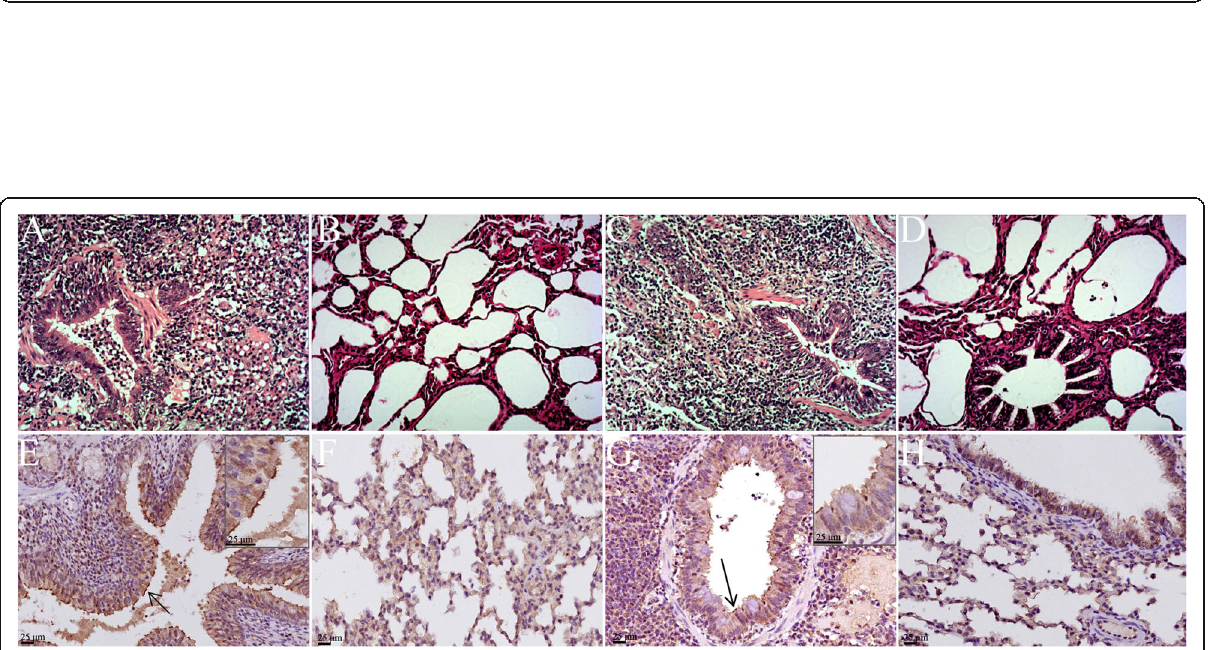
Fig. 4 IFA for the detection of mucus secretion in bronchi (longitudinal section) infected with M. hyopneumoniae. a and b represent immunostaining with MUC5B in bronchi of Bama mininature pigs infected with M. hyopneumoniae strain JS at 200 × magnification and 400 × magnification, respectively. c and d represent immunostaining with MUC5B in bronchi of control group of Bama mininature piglets at 200 × magnification and 400 × magnification,